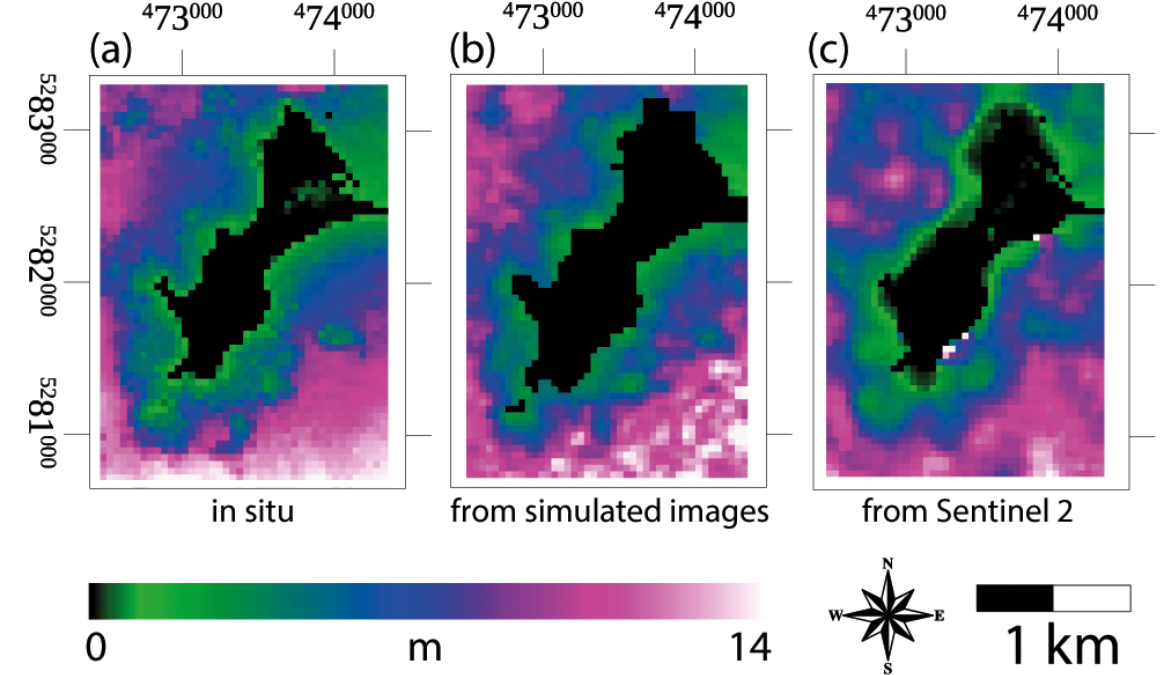
Figure 5. ( a ) In situ bathymetry, ( b ) bathymetry retrieved from the simulated waves, and ( c ) bathymetry retrieved from Sentinel 2. The land masks in ( b , c ) were bigger than in ( a ) because the correlation window of 32 × 32 pixels, associated with a sampling step of 16 pixels, yielded a decrease in the spatial resolution. Each bathymetric map is provided in the NGF-IGN69 vertical reference frame.